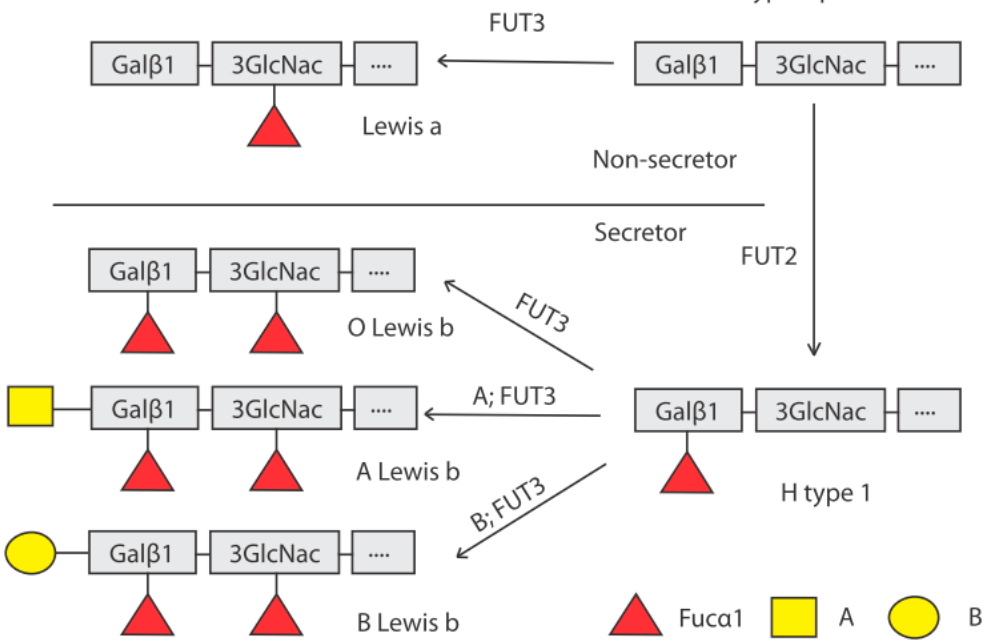
Figure 1. Biosynthesis pathway of histo-blood group antigens (HBGAs) by stepwise addition of monosaccharides to precursor structures. The FUT2 (secretor) gene encodes an α 1,2-fucosyltransferase which adds a fucose residue in α 1,2 linkage to the terminal galactose of the H type 1 precursor. Non-secretors, having a non-functional FUT2 enzyme, cannot synthesize the H type 1 antigen from its precursor and lack α 1,2-linked fucose HBGAs in the intestinal mucosa and other secretions. The synthesis of the A and B antigens by the corresponding enzymes requires the presence of the H type 1 antigen, adding an N -acetylgalactosamine (A) or a galactose (B) in a α 1,4 linkage on the galactose residue of the H type 1 antigen. The Lewis antigens are synthesized with the FUT3 enzyme which adds a α 1,4-linked fucose residue on the N-acetylglucosamine of the H antigen or the H antigen precursor, generating Lewis a or Lewis b antigens respectively. Abbreviations: Gal: galactose; GlcNAc: N -acetylglucosamine; Fuc: